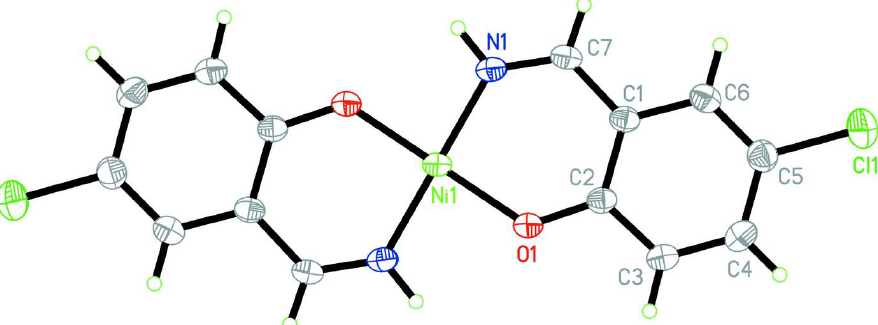
The molecular structure of the title compound, showing 30% probability displacement ellipsoids and the atom-numbering scheme. Unlabelled atoms are related to labelled atoms by the symmetry operation (1 - x, 1 - y, -